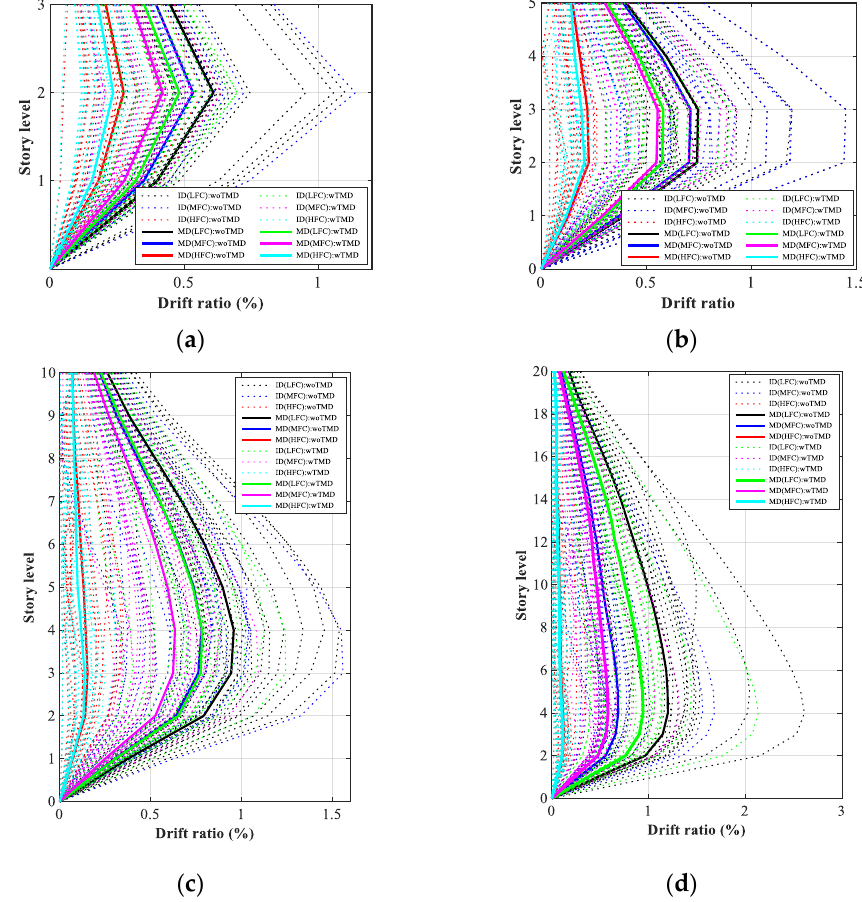
Figure 12. Story displacement of building frames under different categories of GMs: ( a ) 3 story; ( b ) 5 story; ( c ) 10 story; ( d ) 20